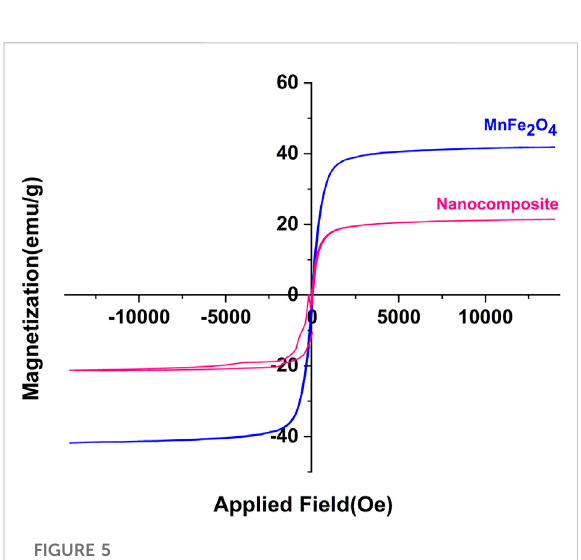
VSM curves of the prepared MnFe 2 O 4 and poly(aniline- co - melamine)@MnFe